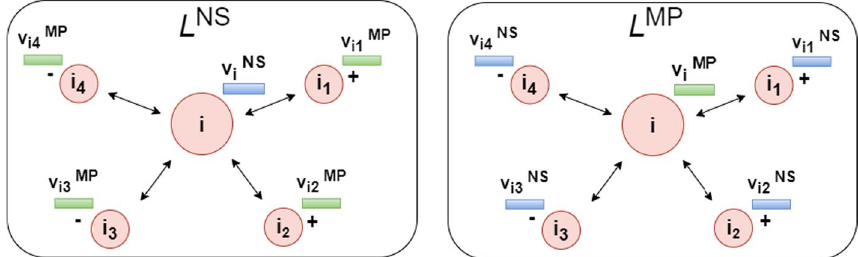
Fig. 9 Illustration of multi-view contrastive learning. For L NS , the embedding of the target entity v i is under the network schema view (colored in blue), while positive ( meta-path view (colored in green). By contrast, for L MP , the embedding of the target entity v i is under the meta-path view (colored in green), while positive ( schema view (colored in